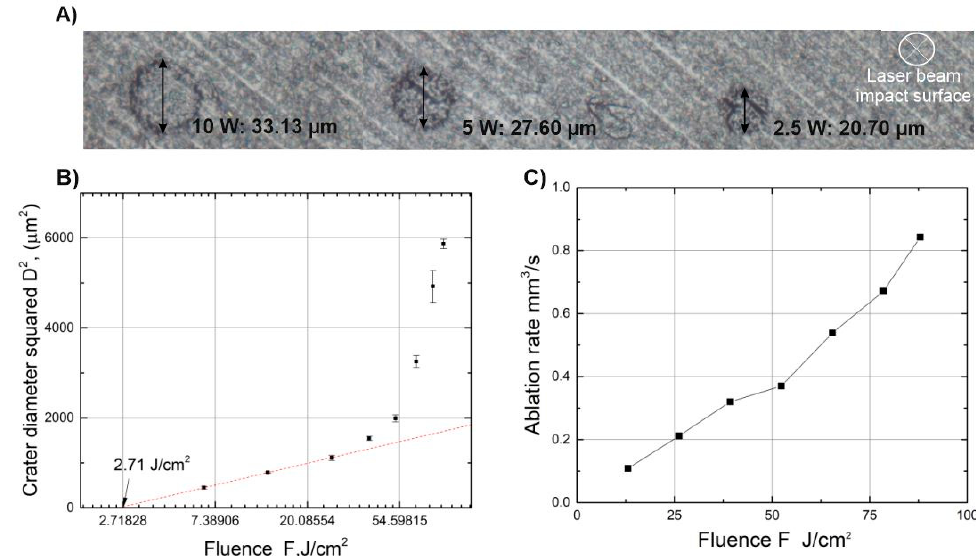
Figure 4. Bright field images of ablated craters taken with “Olympus BX51” microscope ( A ). Crater diameter squared dependence on fluence for ablation threshold retrieval ( B ). Ablation rate dependence on beam fluence ( C ).